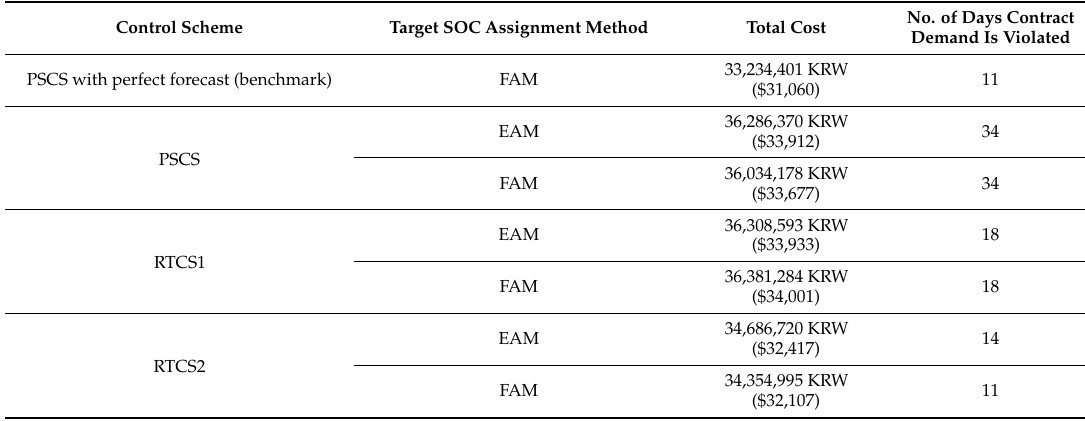
Table 2. Simulation results of continuous operation under various